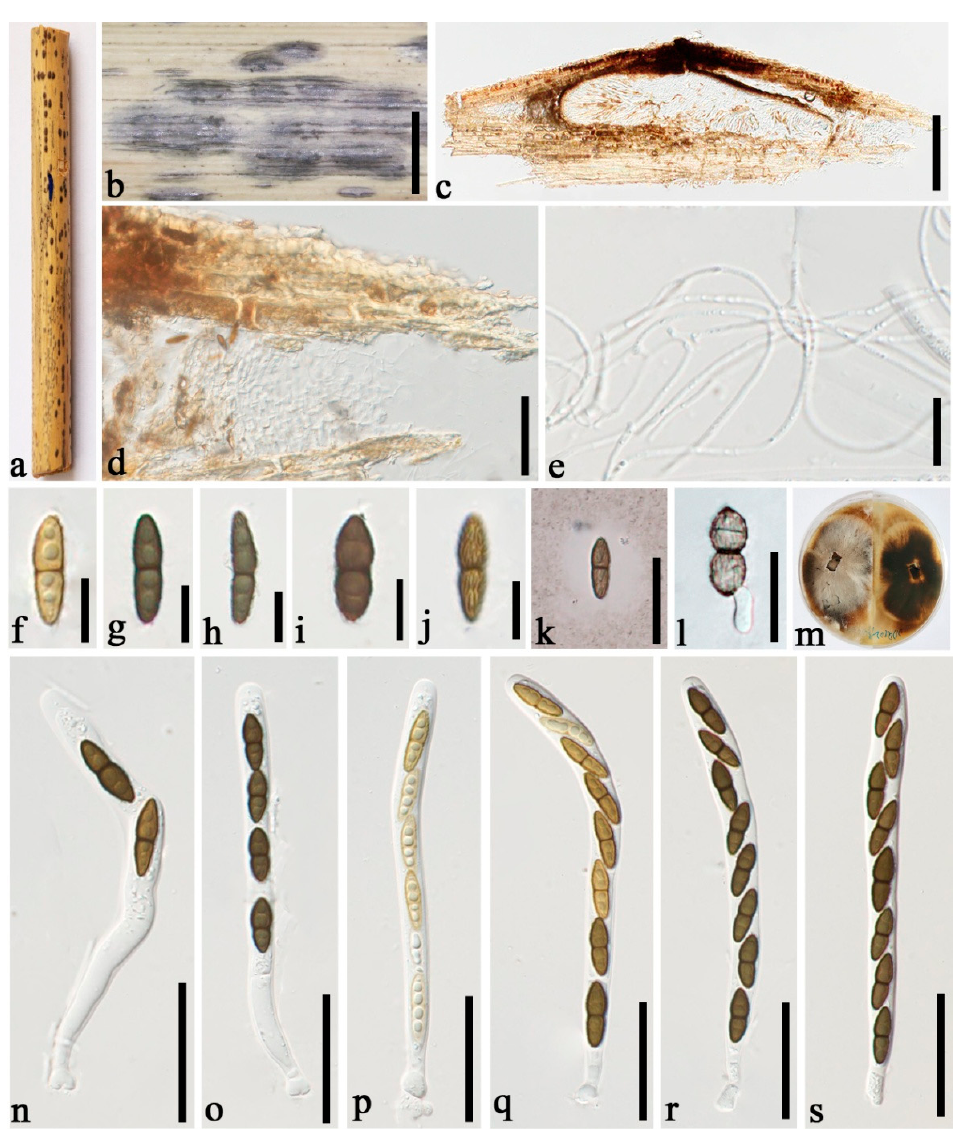
Figure 3. Roussoella japanensis (GMB1292, new country record). ( a ) Bamboo specimen; ( b ) black ascostromata on host surface; ( c ) vertical section of ascoma; ( d ) cells between locules; ( e ) pseudo- paraphyses; ( f – j ) ascospores; ( k ) ascospore in India ink; ( l ) germinating ascospore; ( m ) cultures on PDA from below and above; ( n – s ) asci. Scale bars: ( b ) = 2 mm, ( c ) = 200 μ m, ( d ) = 50 μ m, ( e – j ) = 10 μ m, ( k , l ) = 20 μ m, ( n – s ) = 30 μ m.